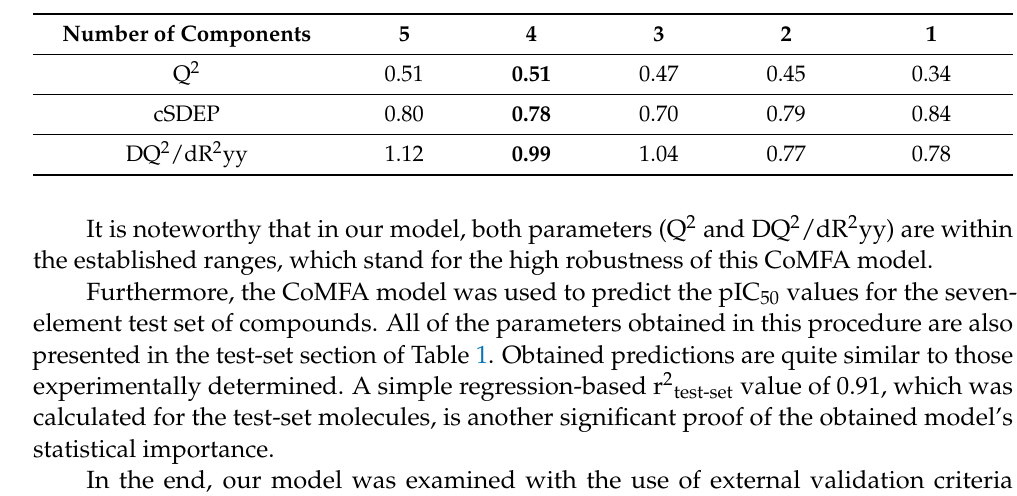
Figure 3. Comparative Molecular Field Analysis (CoMFA) electrostatic (right) and steric (left) fields projected on the 3D structure of the fatty acid amide hydrolase in complex with the least active compound ( 31 ). Fields are drawn with 70/30 proportions. Ligands are depicted as sticks and balls with green carbon atoms. Protein is shown as sticks with gray carbon atoms. Catalytic residues are presented as sticks and are colored using yellow carbon atoms. A bond formed between a ligand and an enzyme is depicted as an orange dashed line. Non-polar hydrogens are omitted for clarity.